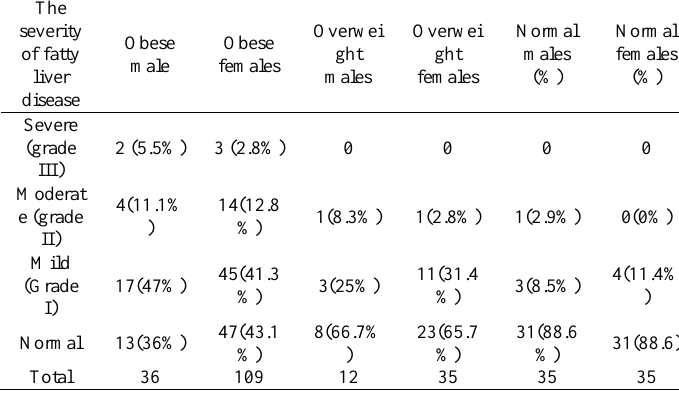
Table 1: NAFLD in relation to BMI and sex